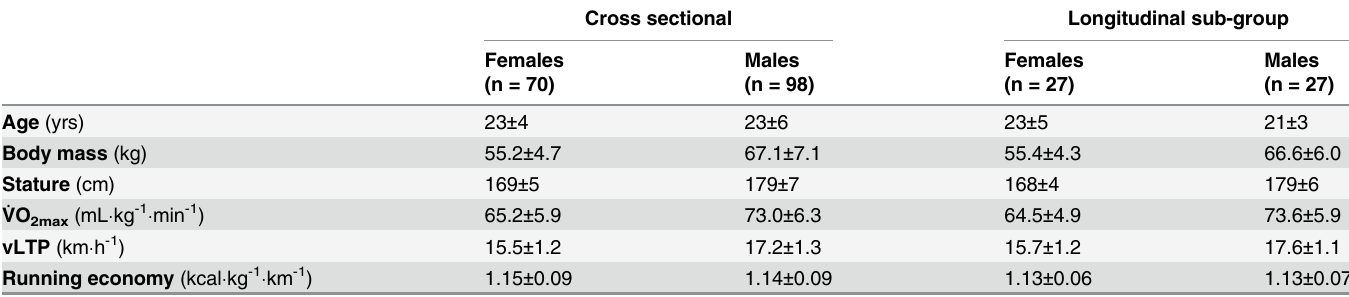
Table 1. Physiological and anthropometrical characteristics of athletes within the cross sectional and longitudinal